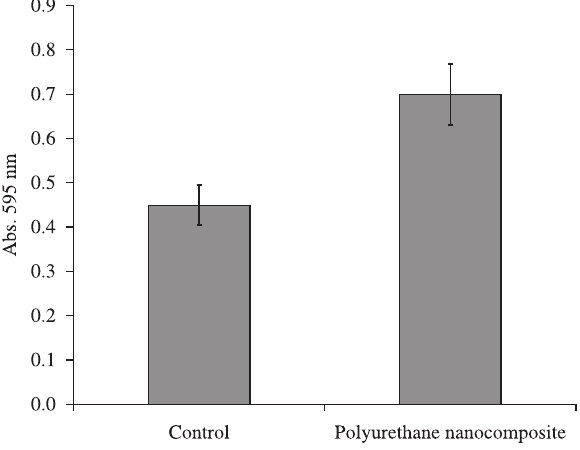
Figure 6. MTT results: osteoblastic cells cultured in contact with PU nanocomposite compared with cells cultured on TCPS (control). The bars indicate standard deviations (p < 0.05).